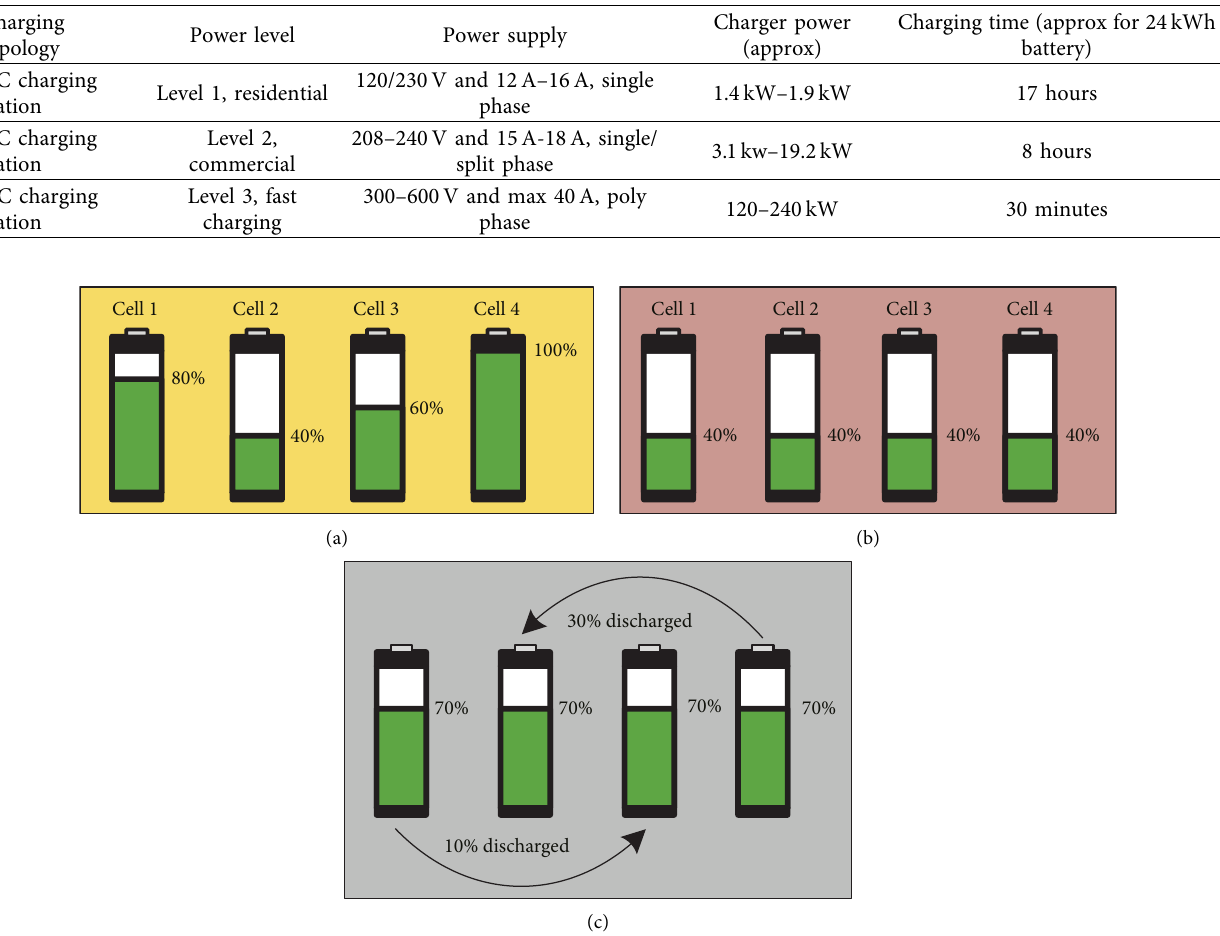
Table 2: Various battery charging topologies for